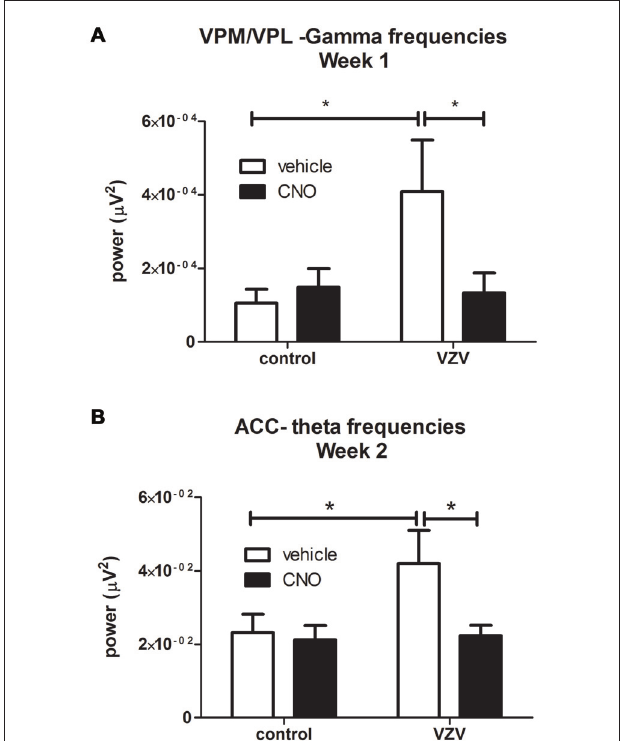
FIGURE 3 | Experiment 3, power spectrum analysis following infusion of the VPM/VPL thalamus with AAV8-hSyn-hM4D(Gi)-mCherry and placement of an electrode in the anterior cingulate cortex (ACC) and VPM/VPL VZV was injected into the whisker pad 1 week after surgery. Local field potential (LFP) recordings were completed in the VPM/VPL (A) and ACC (B) . Thirty minutes before LFP recording the rats were given an injection of either CNO or vehicle (0.9% saline). Testing was completed once a week for 30 min. Testing was performed on three consecutive weeks. Data for week 1 is shown in (A) and the data for week 2 is shown in (B) ; data for week 3 was not significant and is not shown. Asterisk indicates a significant difference of p < 0.05. There were seven animals in each treatment group. The values are the mean ±